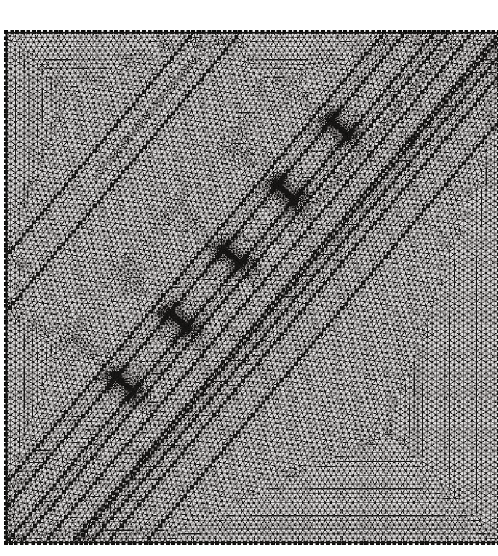
Figure 4: Inclined model and